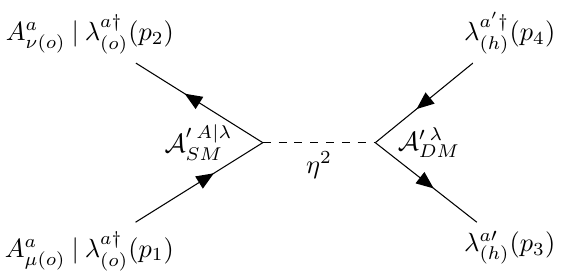
Figure 2. Possible chiral dark matter production mechanisms via the η 2 modulus portal. The massive η 2 modulus can be produced either by boson-boson or gaugino-gaugino scattering in the thermal bath of particles in the observable sector created during reheating. The η 2 modulus can then decay to the hidden sector